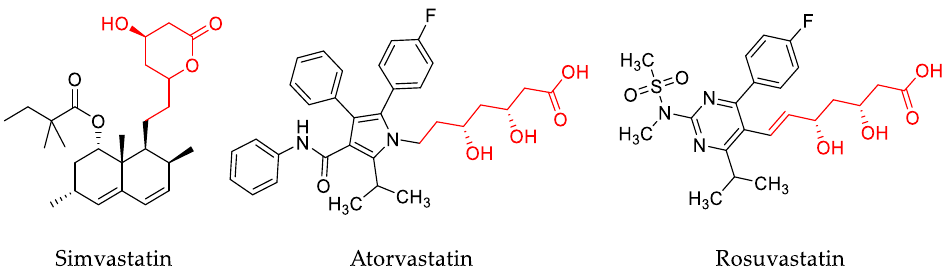
Figure 1. Molecular structures of three statins: Simvastatin, atorvastatin, and rosuvastatin. Dihydroxy heptanoic acid side chain and its cyclic precursor are colored in red.